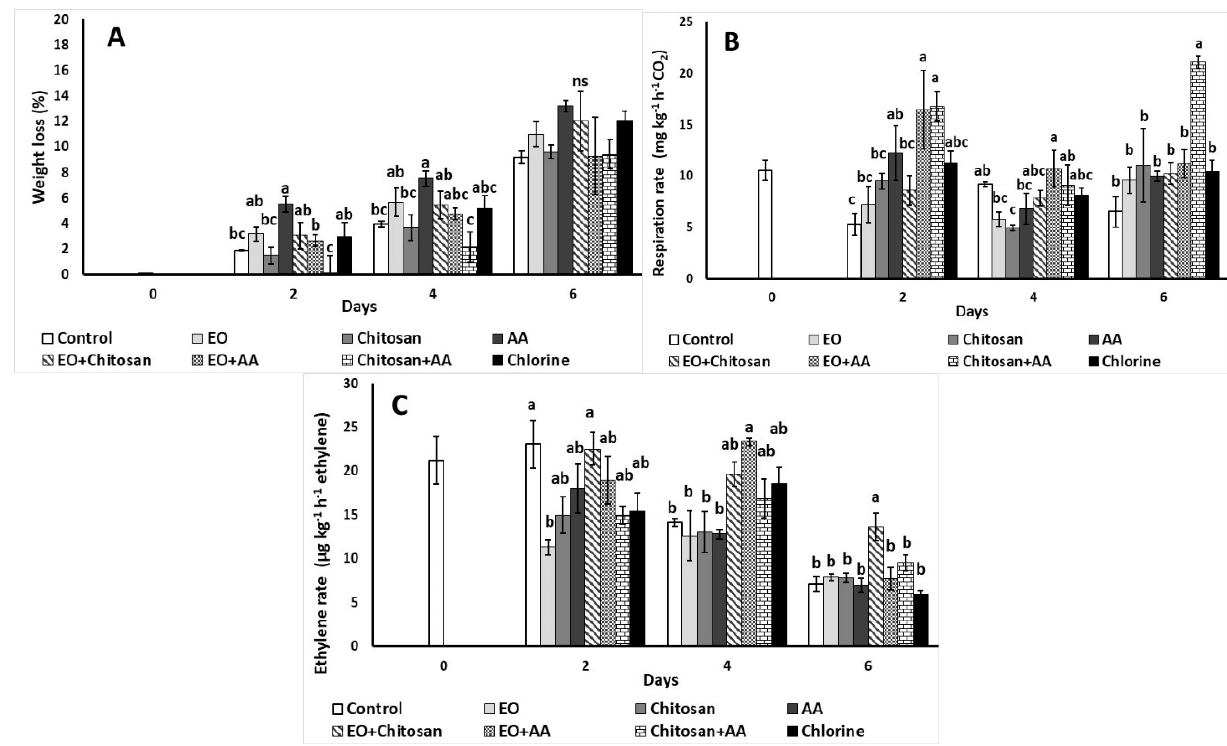
Figure 2. Effect of marjoram essential oil (EO), chitosan, and ascorbic acid (AA) on fresh-cut lettuce ( A ) weight loss (%); ( B ) respiration (mg kg − 1 h − 1 CO 2 ); and ( C ) ethylene ( μ g kg − 1 h − 1 ethylene) rate after treatment and 6 days of storage at 7 °C and 90% RH. On the columns, significant differences ( p < 0.05) among treatments are indicated by different Latin letters; ns indicates no significant differences for different days. Values represent means (±SE) of measurements made on three biological replicates per treatment.